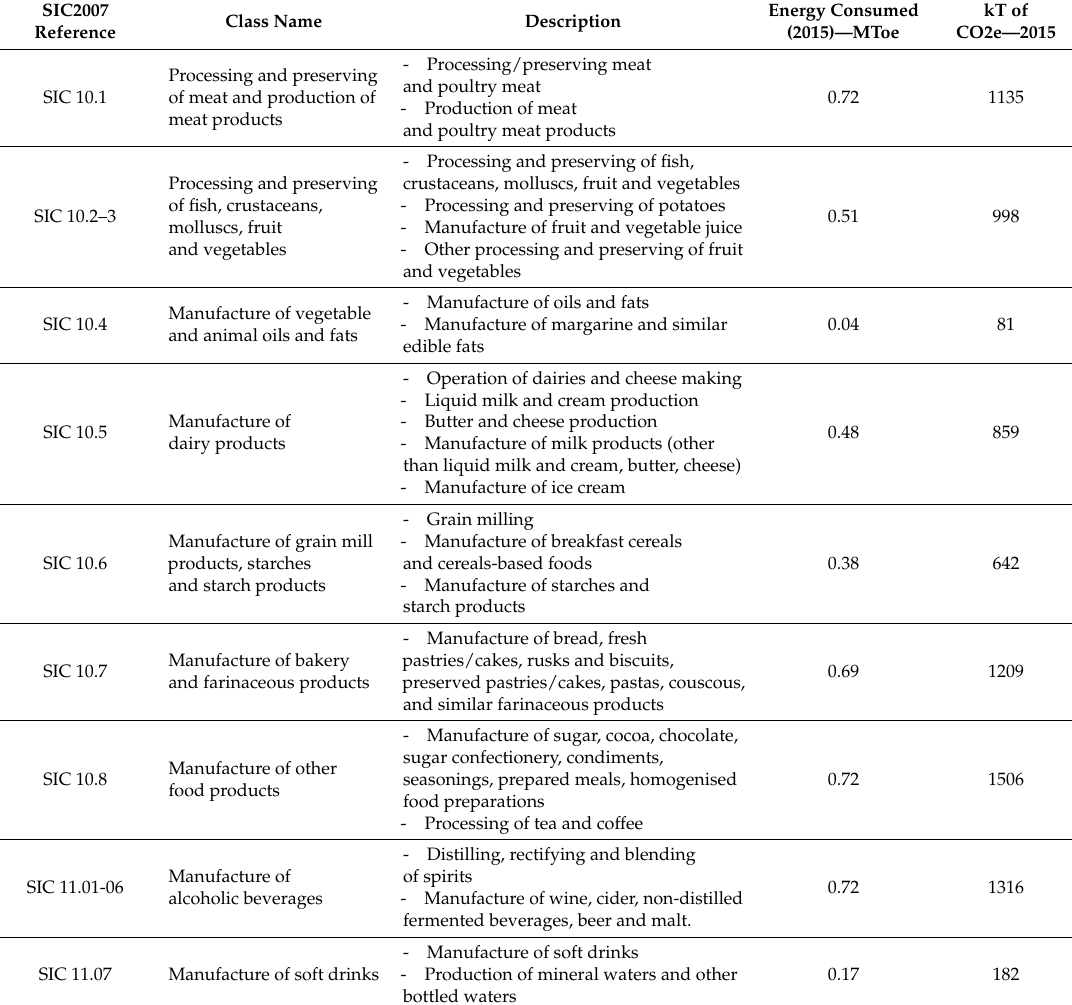
Table 1. SIC2007 breakdown of food manufacturing industry